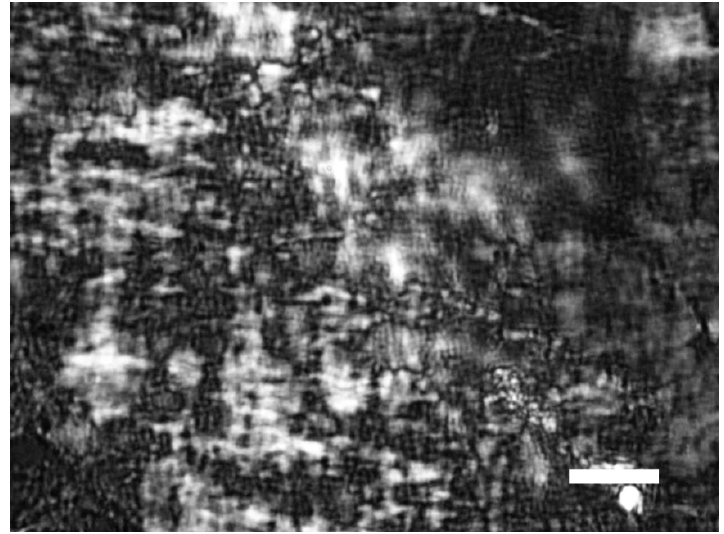
Figure 1. Polarization microscopy images of spherical particle-like pDNA-HCcp3 liquid crystalline condensates with a bp to dimer ratio of 20 to 1. The pDNA is the pUC18 plasmid. The birefringence (white and dark color) presented in figure indicated liquid crystalline phase. Scale bar in panel: 20